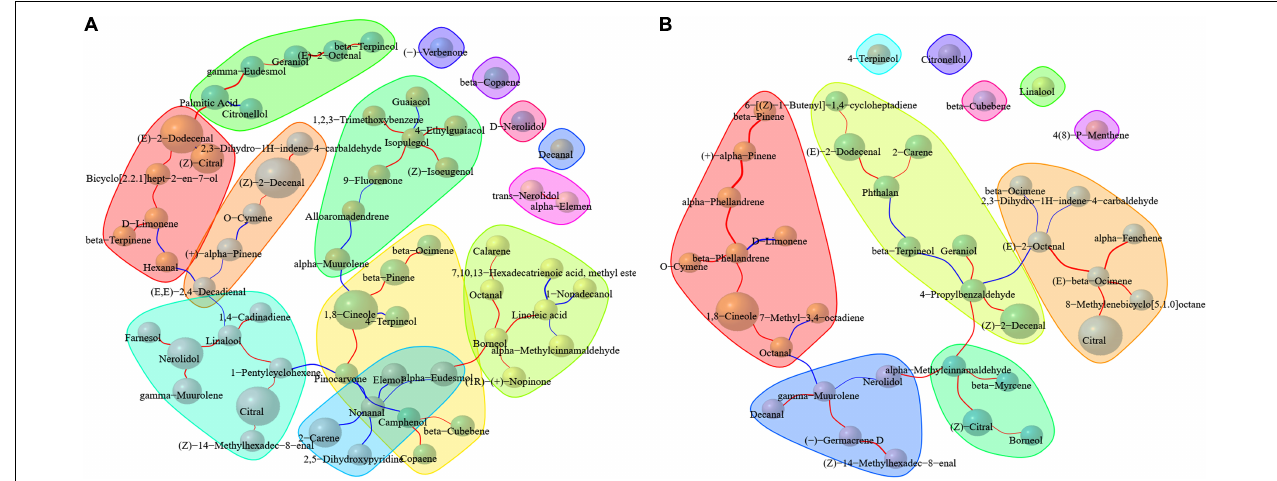
FIGURE 4 | Correlation of volatiles in the pericarp (A) and kernel (B) of A. tsao-ko with different pre-drying and drying methods.